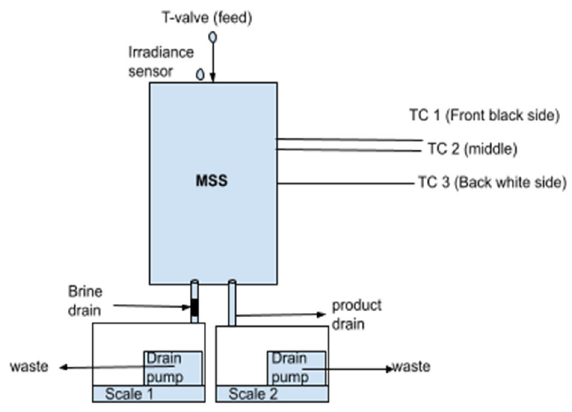
Figure 7. Prototype setup front view.